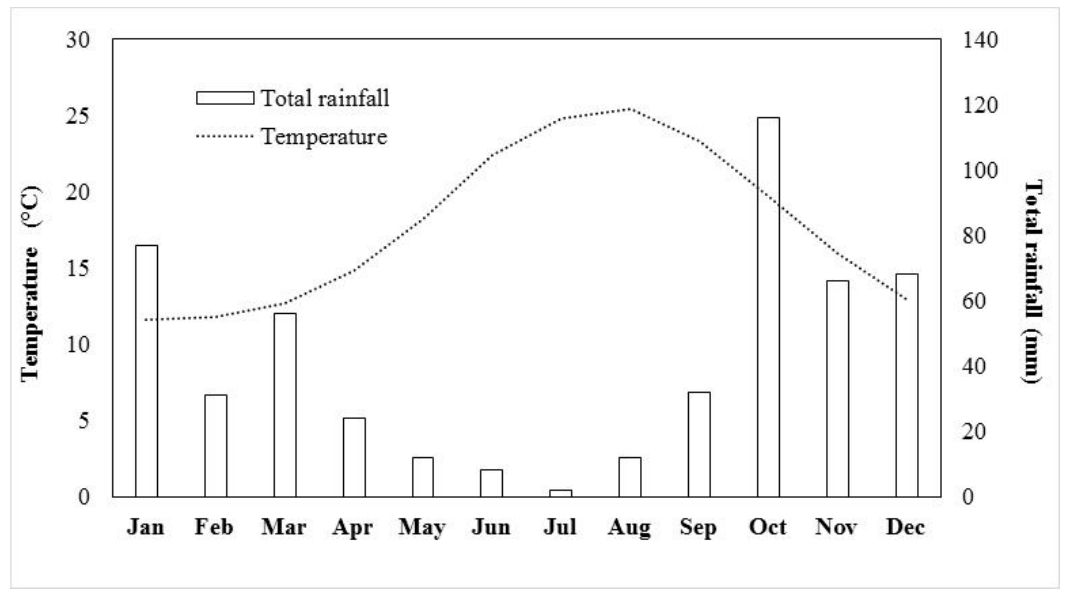
Figure 1. Climatic ombrothermic diagram at the experimental field site (average data from 1965 to 1994).